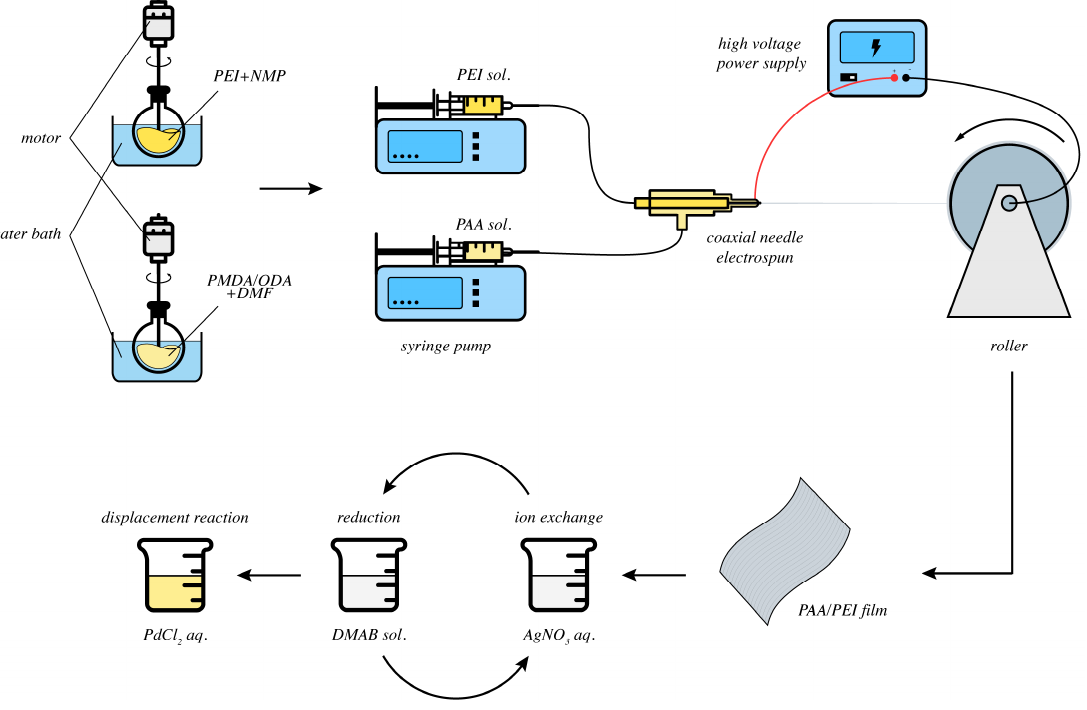
Figure 1. Schematic of the synthesis of our palladium-coated composite material.